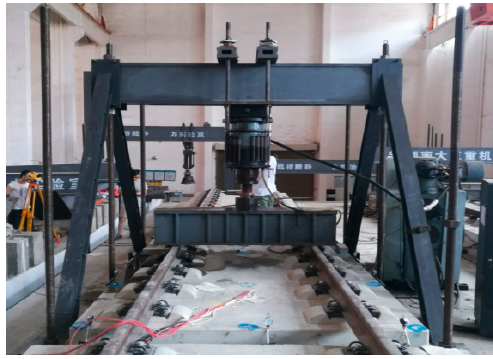
Figure 10. Loading device.